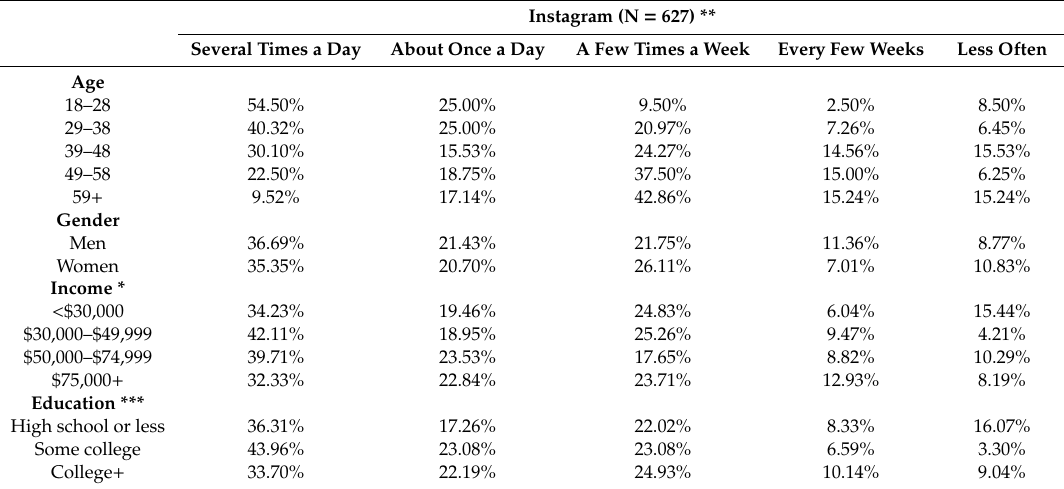
Table A3. Overview of Instagram users (own elaboration).